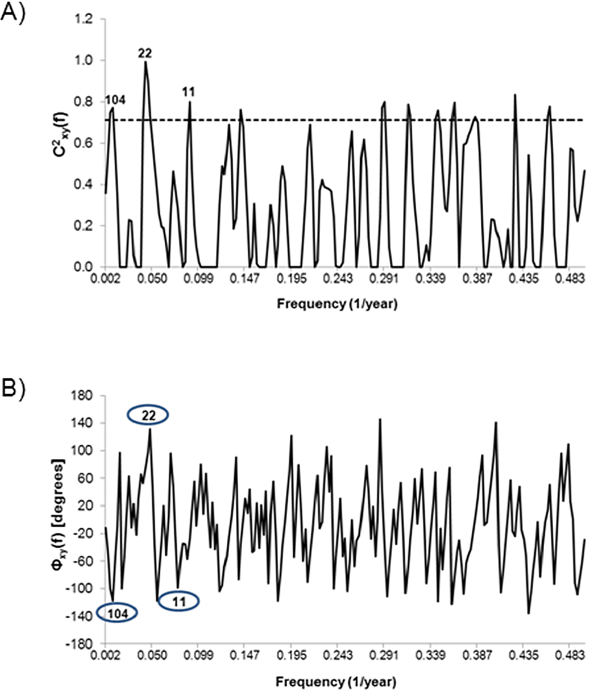
Figure 5. Cross-spectral analysis between the index of summer flood damage INU and annual number of sunspots: (a) Coherency spectrum. Dashed line indicates false-alarm level for α = 0.1. (b) Phase spectrum. The sign of the INU data was changed prior to cross-spectral analysis in order to prevent an artificial phase offset by ± 180 ◦ . Negative angles indicate that the maximum frequency in the floods occurs during a solar activity minimum and vice